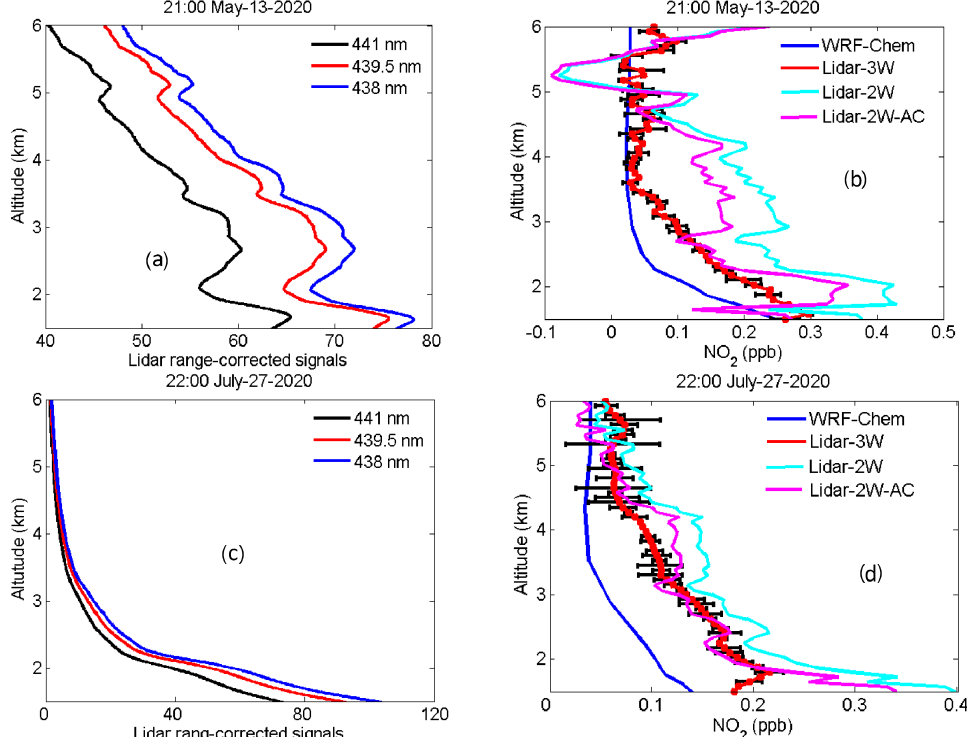
Figure 13. HU lidar 438, 439.5 and 441nm elastic signals measured at 21:00LT on 13 May 2020 (a) and 22:00LT on 27 July 2020 (c) ; NO 2 profiles obtained using the three-wavelength DIAL technique, two-wavelength DIAL technique and WRF-Chem model at 21:00LT on 13 May 2020 (b) and 22:00LT on 27 July 2020 (d)